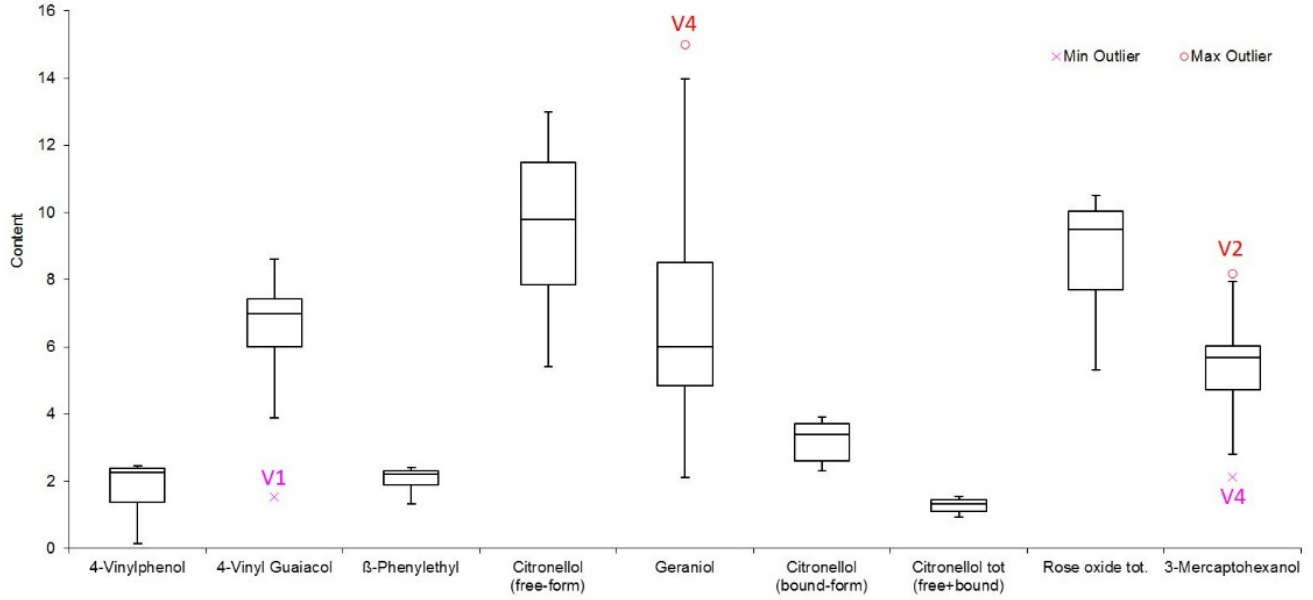
Figure 12. Boxplot of polyphenols measured in the wines. The circles and cross symbols represent respectively the maximum and minimum statistical outliers. Beside the outlier is the vineyard label. Table 9. Grubbs and Dixon